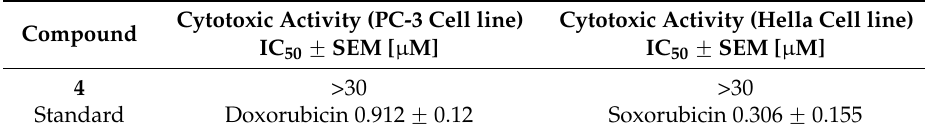
Table 6. Results of cytotoxicity assays of compound 4